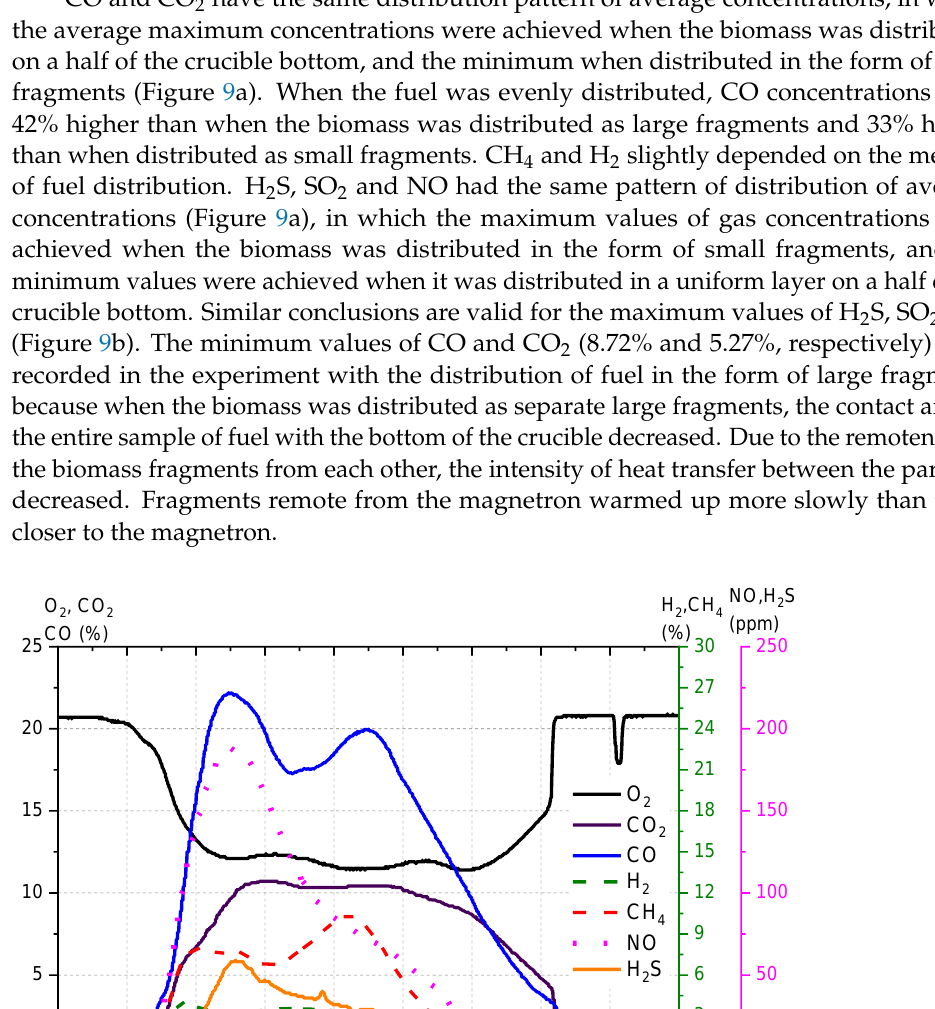
Figure 7. Distribution of the fuel sample in the crucible: a set of large fragments ( a ), a set of small fragments ( b ), on a half of the crucible bottom ( c ).